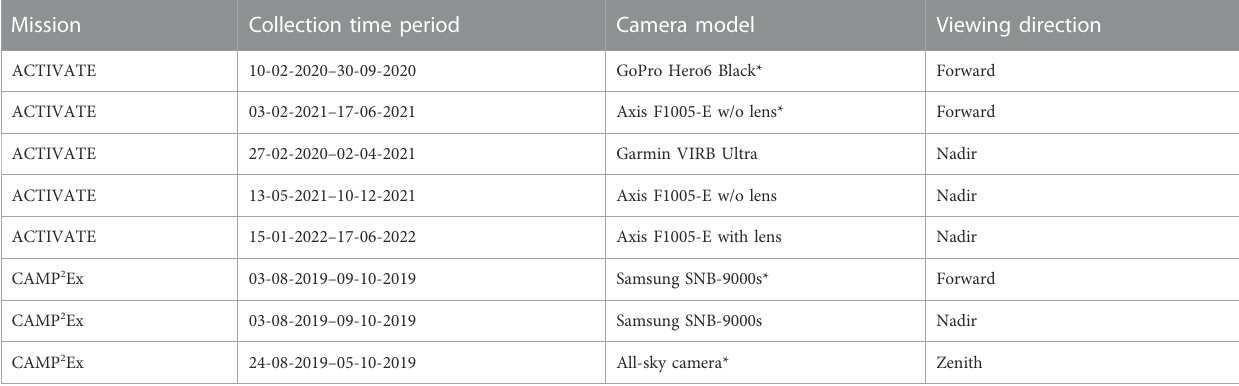
TABLE 1 Airborne cameras are used in the NASA ACTIVATE and CAMP 2 Ex campaigns. This table indicates the different camera models used in the ACTIVATE and CAMP 2 Ex fl ightcampaigns.Wereportthetimeperiodsthatdifferentcameramodelscollectedimagesduringeachmission,butitshouldbenotedthatthesedates mayincludetest fl ightsandthusmaydifferfromtheof fi cialdatesforeachcampaign.Entrieswithanasteriskindicatethecamerasthatrecordeddatausedtotrain and test our CDNNs. Mission